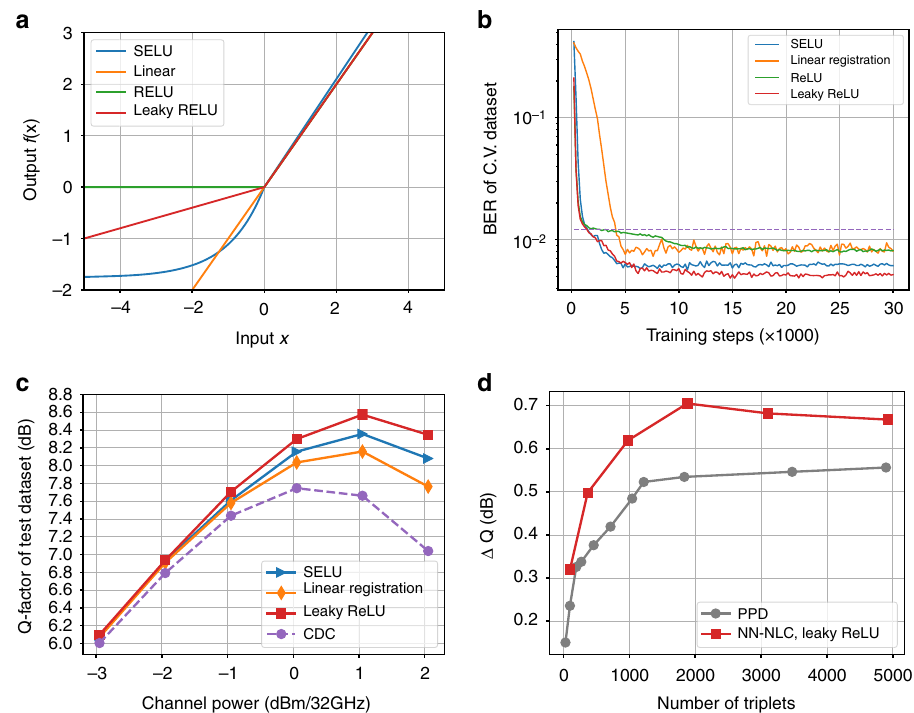
Fig. 5 The impact of activation function on the NN-NLC algorithm. a Plots of different activation functions. b The BER optimization trace of DNN over the CV dataset in the training with different activation functions. c The Q-factor of DNN with different activation functions as a function of channel power. d The Q-factor improvement of PPD and NN-NLC with Leaky ReLU w.r.t. the optimum CDC